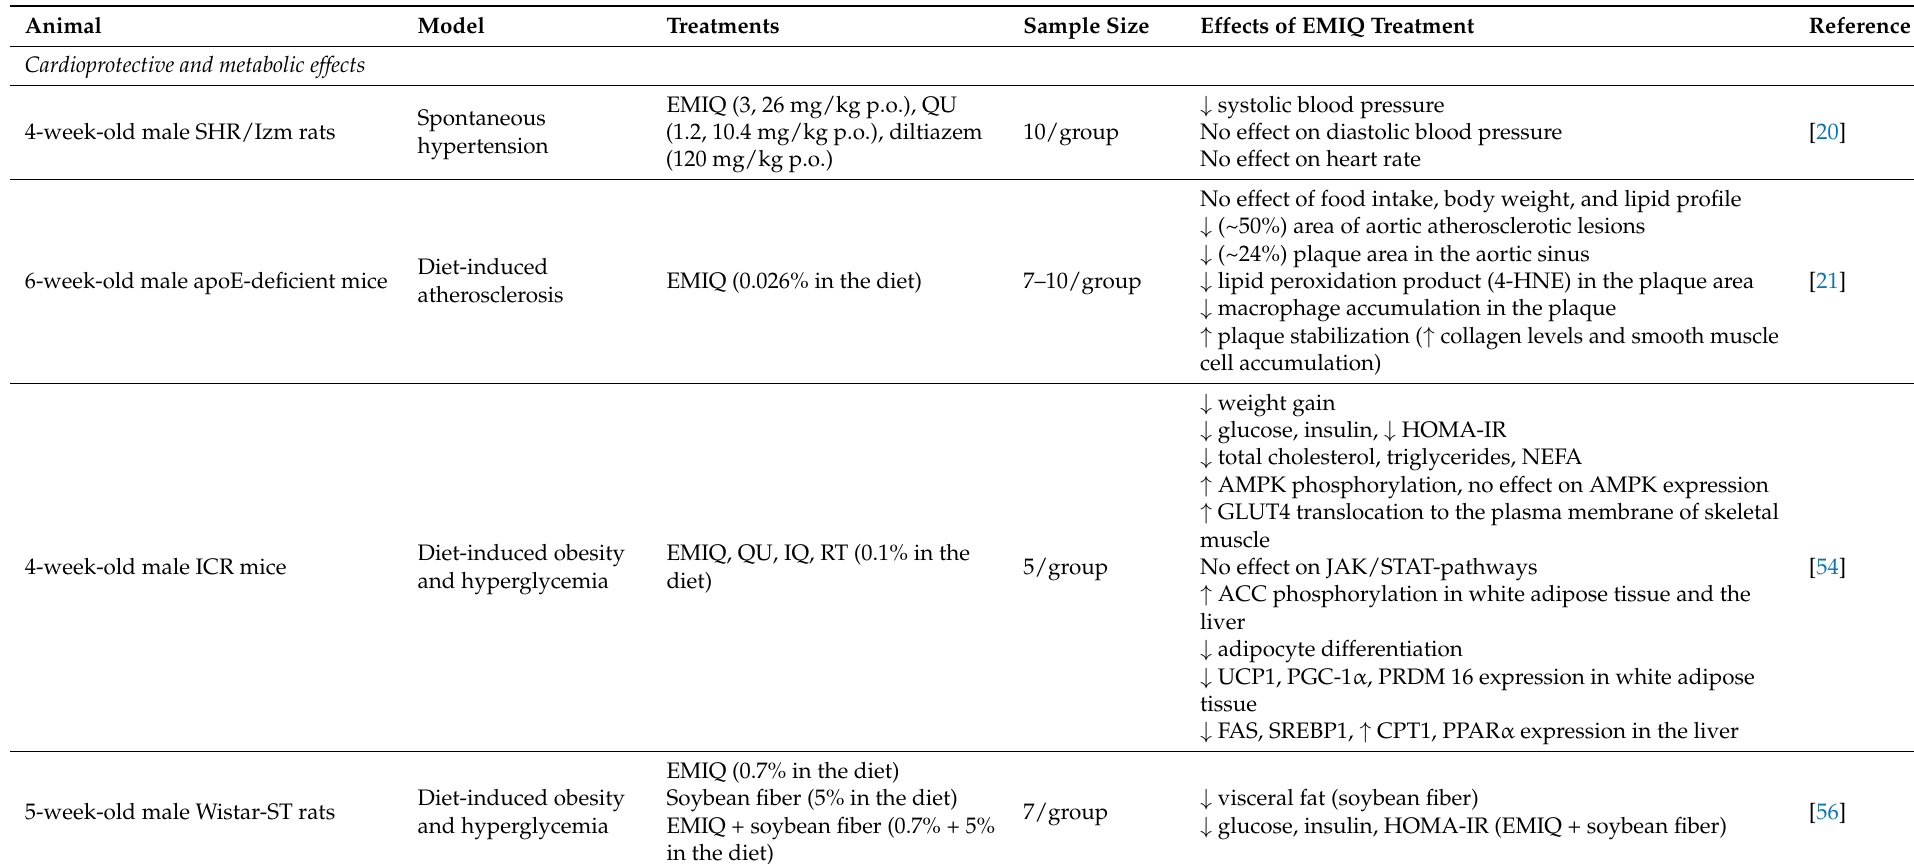
Table 3. Bioactivity studies of